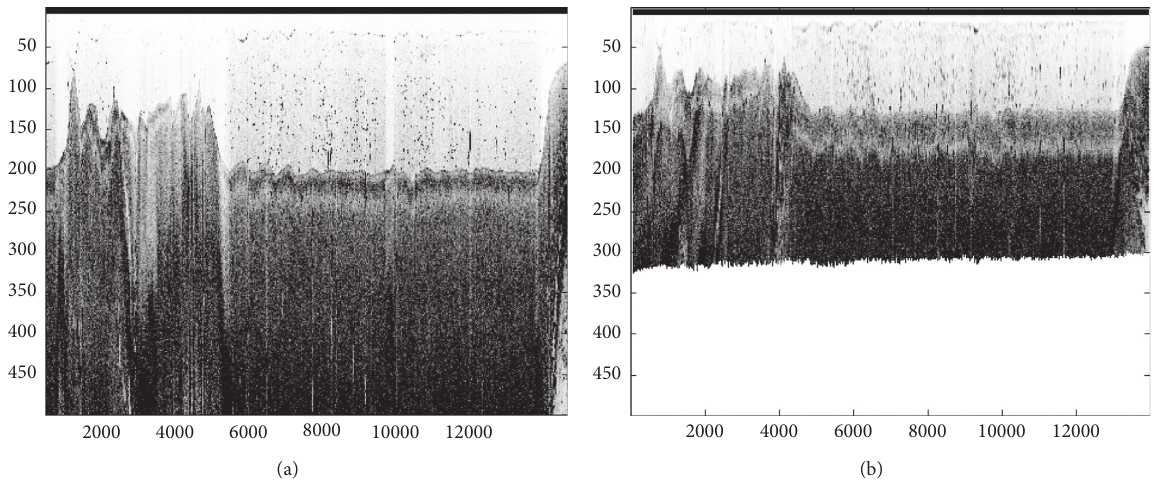
Figure 4: Separate SSS images for port and starboard sides with blind zone: (a) port side and (b) starboard side.